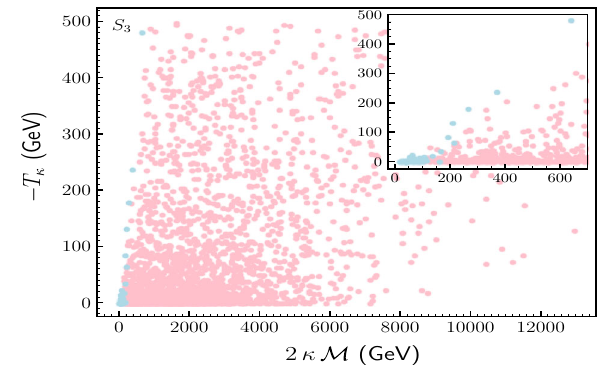
Fig. 15 Viable points of the parameter space for S 3 in the − T κ versus 2 κ M plane. The color code is the same as in Fig. 12. In the upper right we zoom in the region with light-blue points As discussed in Sect. 3.1, the push-down effect (together with negative loop corrections) of a heavy singlet-like sec- tor is more favourable to reproduce the SM-like Higgs mass. In Table 12 of Appendix C, we show the BP S3- R1 corresponding to the light-red region of Fig. 12. In this case, h 2 is the SM-like Higgs, and the right sneutri- nos are very mixed as expected from the large value of λ . In Fig. 14, we show the singlet component of the singlet-like scalars. As for the other scans, scalars with large masses and with a very large doublet composition can also be present